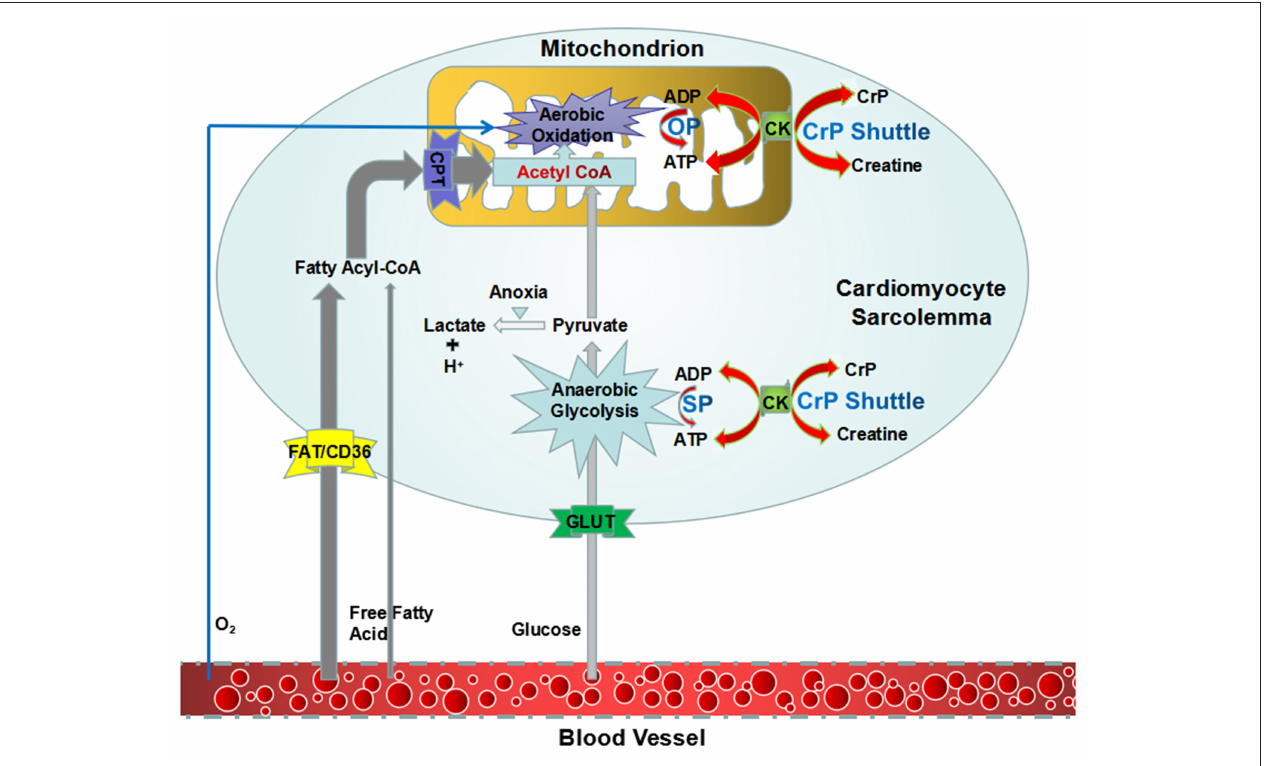
FIGURE 1 | An overview of synthesis of ATP and “CrP shuttle” in cardiomyocyte. ATP is the intracellular energy currency, majority of which is synthesized from ADP by oxidative phosphorylation of mitochondria (predominant) and cytoplasmic substrate phosphorylation (subordinate). CrP is the storage and transport carrier of energy, which serves to transfer the HEP-bond from the site of ATP production to the site of ATP utilization through “CrP shuttle.” ADP, adenosine diphosphate; ATP, adenosine triphosphate; CK, creatine kinase; CrP, creatine phosphate; HEP, high-energy phosphate; OP, oxidative phosphorylation; SP, substrate phosphorylation.